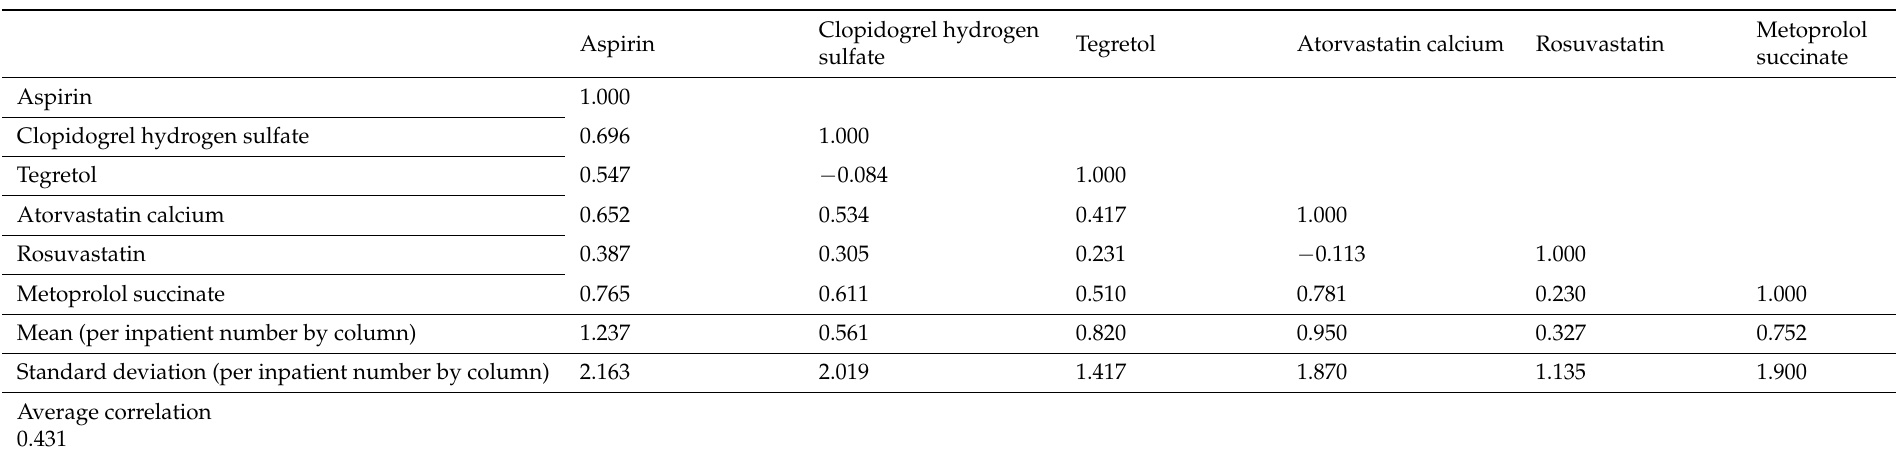
Table 6. The comparison of the correlation analysis results for medicines used for Scenario One’s study using counts variable.